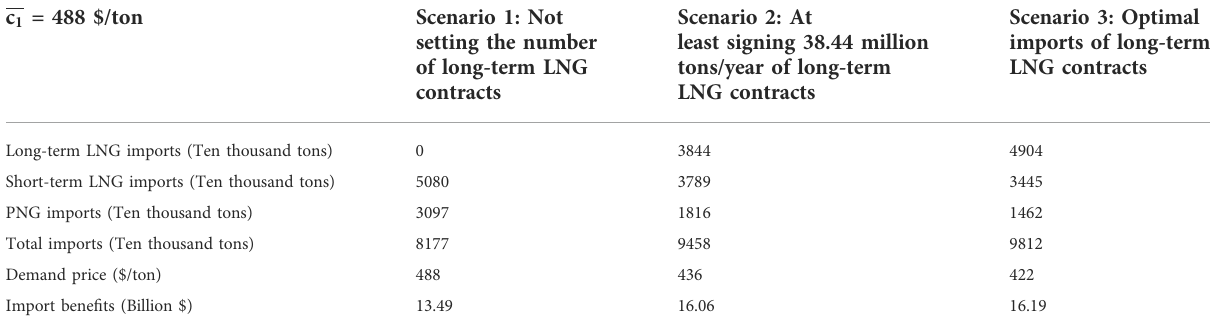
TABLE 2 Impact of long-term LNG contracts on China ’ s gas